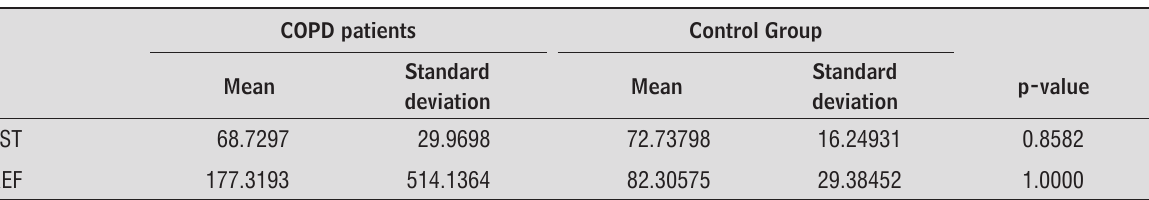
Table 3 - Descriptive measures and comparison of the values in the Foam-Laser Dynamic Posturography tests performed by individuals with GOLD II and GOLD III COPD COPD GOLD II COPD GOLD III Standard Mean deviation